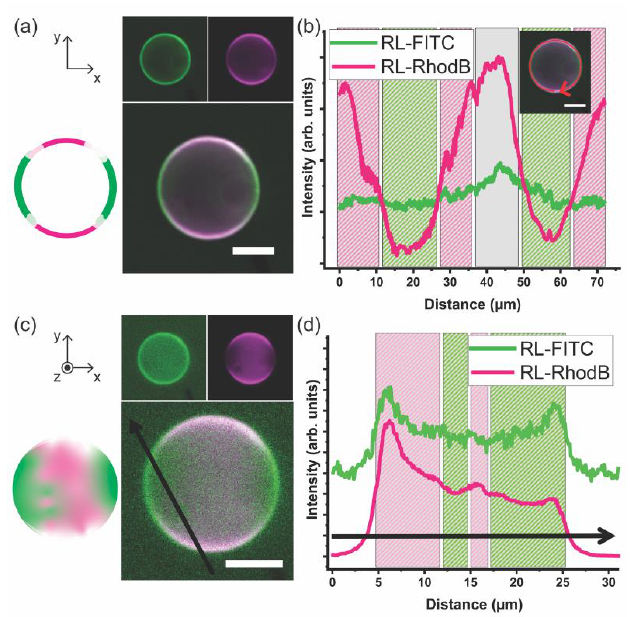
Figure 4. ( a ) 2D cross-sectional CLSM images of the DPPC–mPEG- b -PCL giant hybrid unilamellar vesicle (GHUV) (80 mol% DPPC and 20 mol% mPEG- b -PCL). (mPEG- b -PCL)-FITC and 16:0 Liss Rhod PE were used to tag BCP and PL domains, respectively. RL-FITC fluorescence in green (excitation laser at 488 nm / detection wavelength 400–544 nm) and RL-Rhod B fluorescence in magenta (excitation laser at 561 nm / detection wavelength 558–700 nm) are in separate channels on the top and the merged image of RL-FITC and RL-Rhod B channels is shown at the bottom. Left inset is a graphical illustration of the merged image. ( b ) 1D profile of each channel along the vesicle membrane in ( a ). ( c ) a Z-stack projection of height-resolved CLSM images of an upper hemisphere of the DPPC–mPEG- b -PCL GHUV (3D reconstruction). (mPEG- b -PCL)-FITC and 16:0 Liss Rhod PE were used to tag polymer domains and lipid domains, respectively. RL-FITC fluorescence in green (excitation laser at 488 nm / detection wavelength 400–544 nm) and RL-Rhod B fluorescence in magenta (excitation laser at 561 nm / detection wavelength 558–700 nm) are in separate channels on the top and the merged image of RL-FITC and RL-Rhod B channels is shown at the bottom. Left inset is a graphical illustration of the merged image. ( d ) 1D profile of each channel across the Z -axis projection image of the vesicle in ( c ). The internal and external medium of the vesicles is MilliQ water. Scale bar: 10 µ m. Images were obtained on EC Plan-Neofluar 10 × / 0.3 Ph 1 objective lens. Z-stack thickness: 1 µ m.